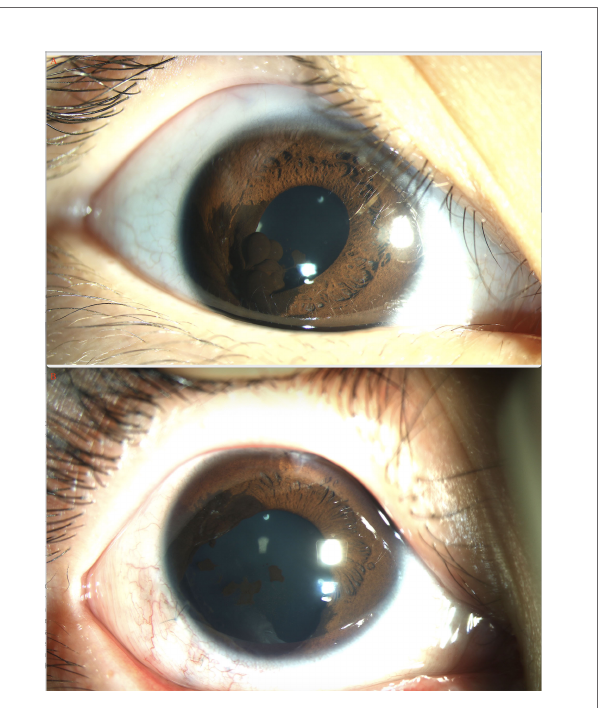
FIGURE 2 | Iris melanocytoma (arrow) of a 7-year-old girl before (A) and after (B)